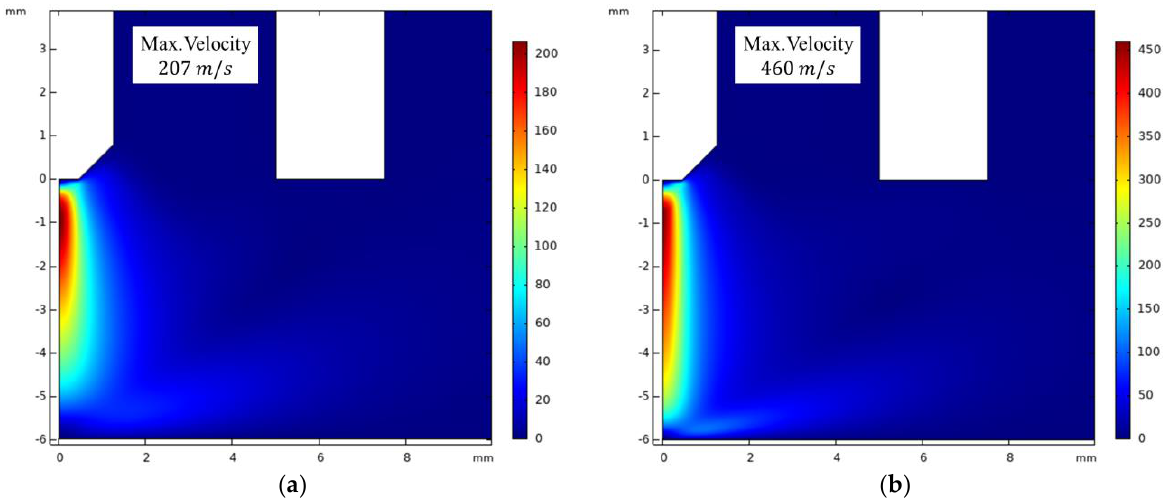
Figure 6. Velocity distribution of arc plasma for the current of ( a ) 100 A; ( b ) 150 A.